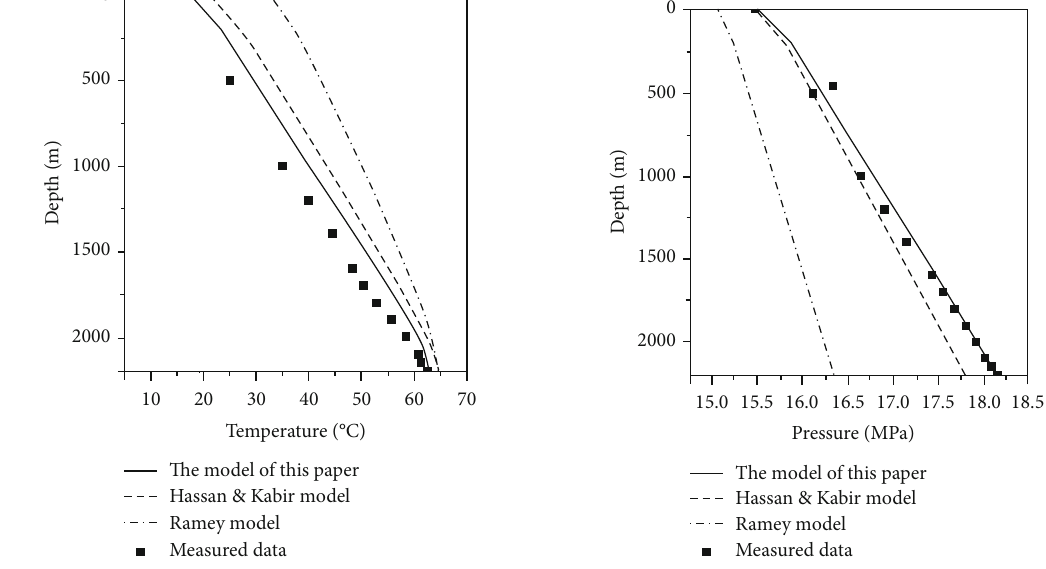
Figure 3: Wellbore temperature and pressure